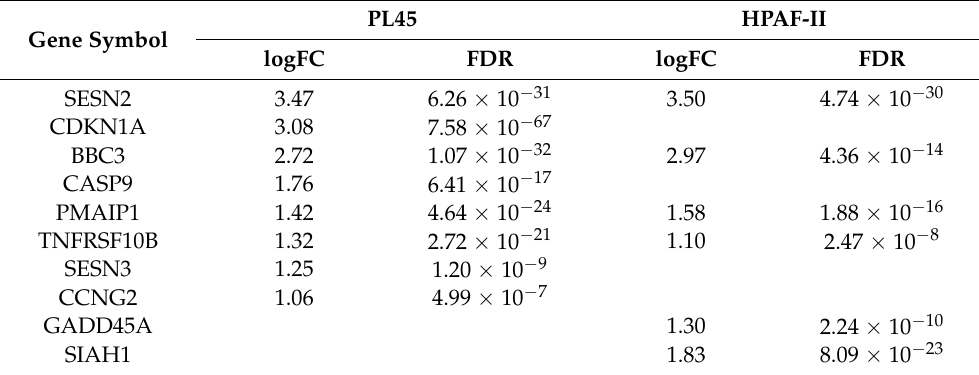
Table 3. Upregulation of P53 signaling pathway-related genes in PL45 and HPAF-II cells following the treatment with CSE. Significantly different control and CS-treated PL45 and HPAF-II cells (FDR- adjusted q-value <0.05). Bold gene names are mutual for both cell lines.